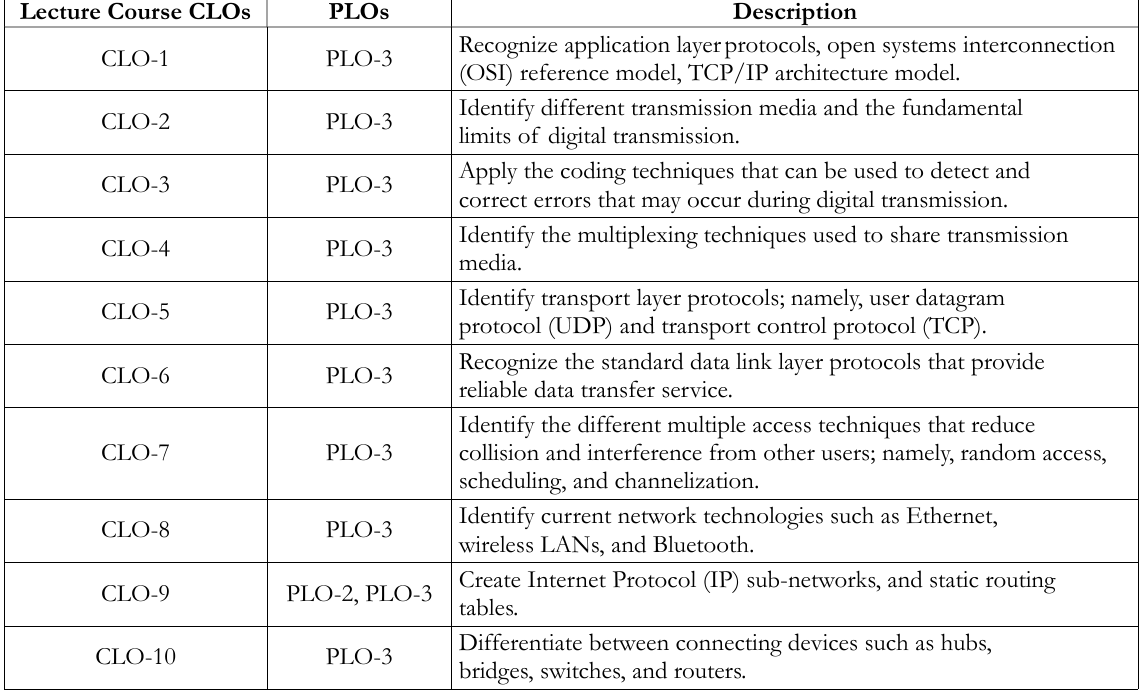
Table 2. The course learning outcomes for the lecture-based course mapped to the program learning